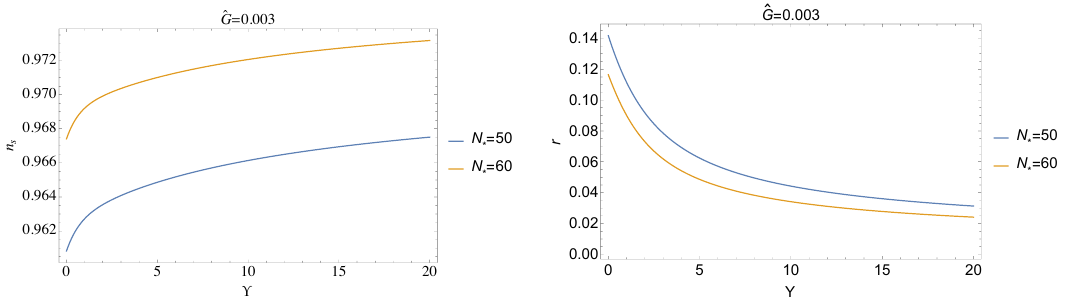
Figure 6 . Spectral index n s and tensor-to-scalar ratio r in terms of (cid:7) with ^ G = 0 : 003 for N (cid:3) = 50 and N (cid:3) = 60